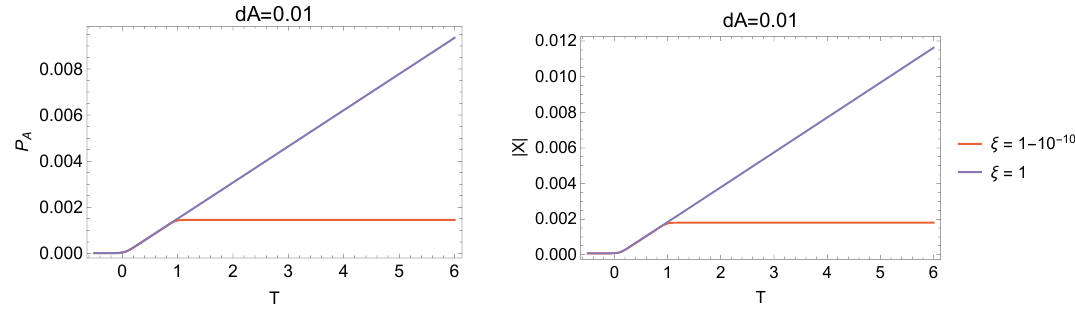
p 48 (cid:25) , (cid:17) = 23,